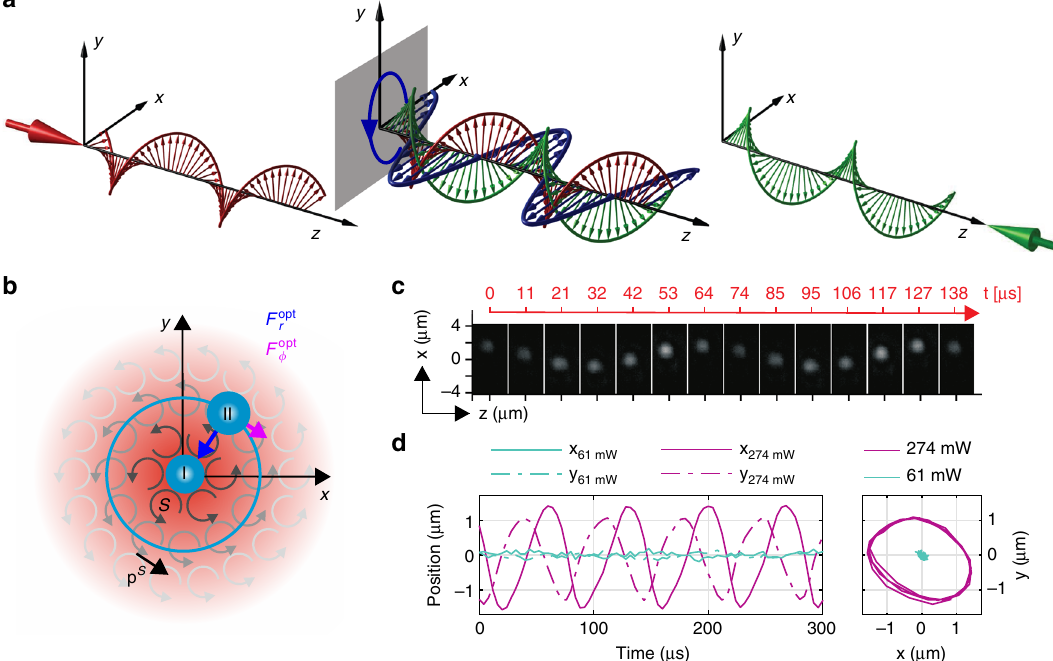
Fig. 1 Physical principles of the experiment. a Schematic showing the electric fi elds in the counter-propagating circularly polarized beams of opposing handedness (green and red) and the rotation of the combined electric fi eld (blue). b Local optical spin ( S = ℑ ( E * × E)) fi eld in the transverse xy plane of the beam. Radial gradient optical force F opt r and azimuthal non-conservative spin force, F opt ϕ acting upon a particle positioned off-axis. Regime I corresponds to the particle position in the vicinity of the beam axis for lower laser power, whereas regime II corresponds to the above threshold condition, in which the particle orbits the beam axis. c Snapshots of orbiting particle (regime II) taken by the CCD camera oriented perpendicularly to the beam propagation. d Trajectories of the particle for both regimes I and II acquired by a QPD. Turquoise curves denote trajectories for a lower trapping power of 55 mW with particle motion near the beam axis; pink trajectories show an orbiting particle for an above threshold power of 180